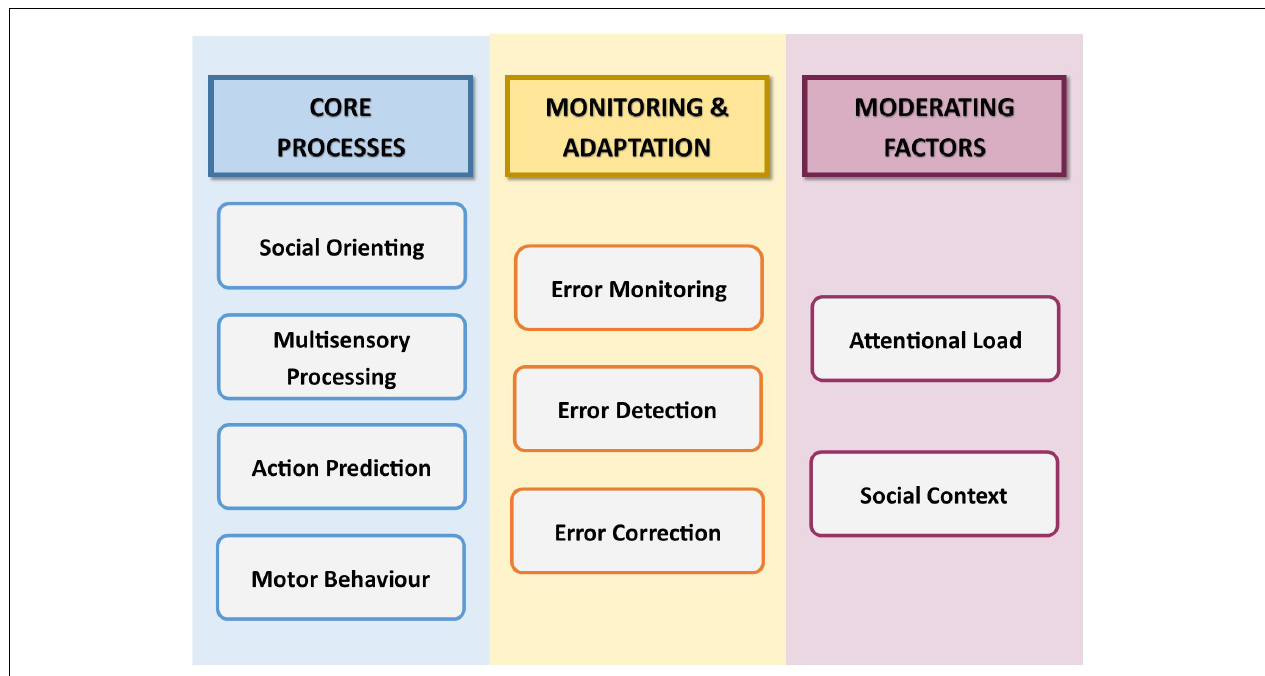
FIGURE 1 | Schematic illustration of the components of non-verbal interpersonal synchrony, as discussed in this review.